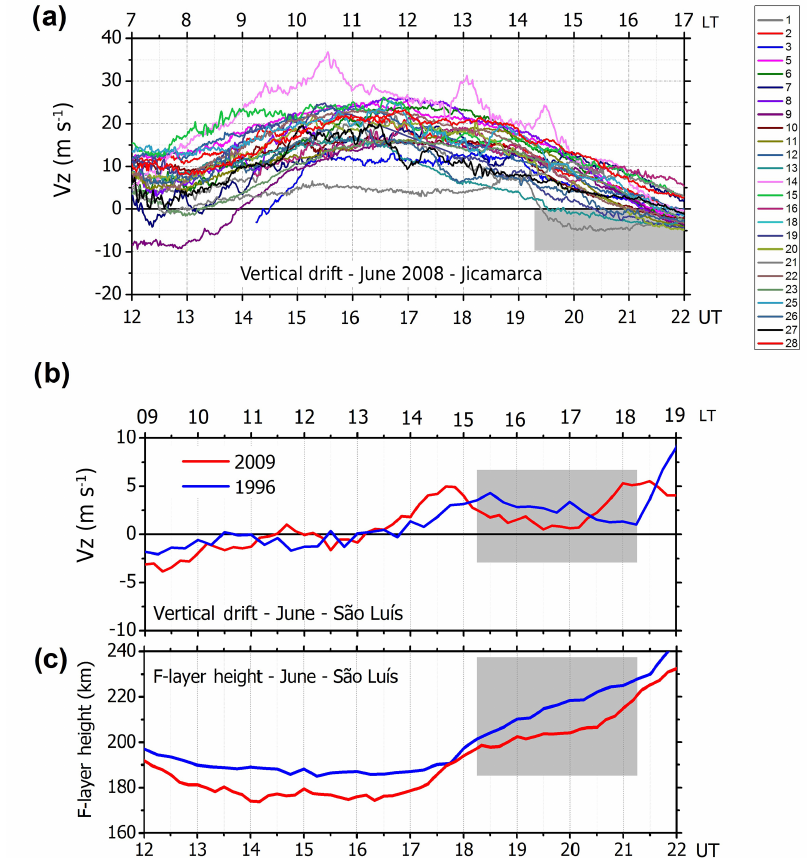
Figure 5. (a) The vertical plasma drifts from magnetometers (Jic-Piu) for almost all days of June 2008. (b) The mean vertical plasma drifts for June (calculated as the average of the drifts at plasma frequencies 4 and 5MHz) over São Luis-Brazil during the solar cycle 23 (1996) and solar cycle 24 (2009). (c) The F-layer heights (taken as the mean of the heights at 4 and 5MHz plasma frequencies) for June 1996 and 2009. The shaded area indicates the anomalous behavior of the vertical drift that is discussed in the